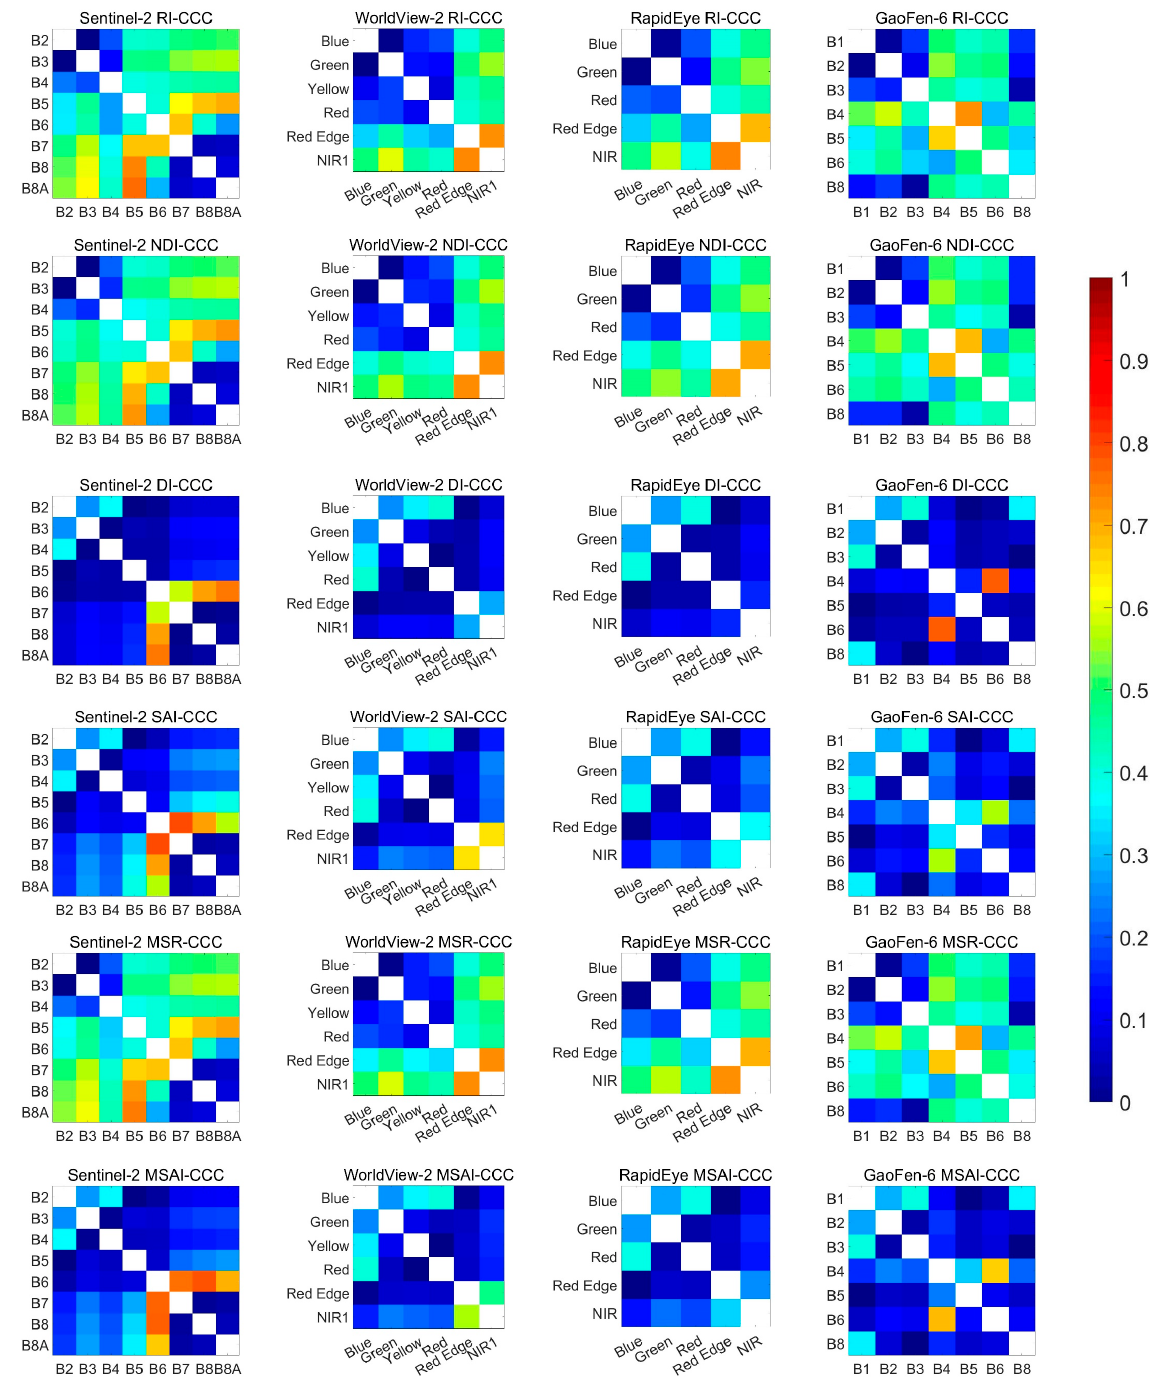
Figure A2. Map of the coefficient of determination between the CCC ( R 2 CCC ) and vegetation indices using all two band combinations based on the RI, NDVI, DI, SAI, MSR and MSAI formulations. The color indicates different R 2 values.